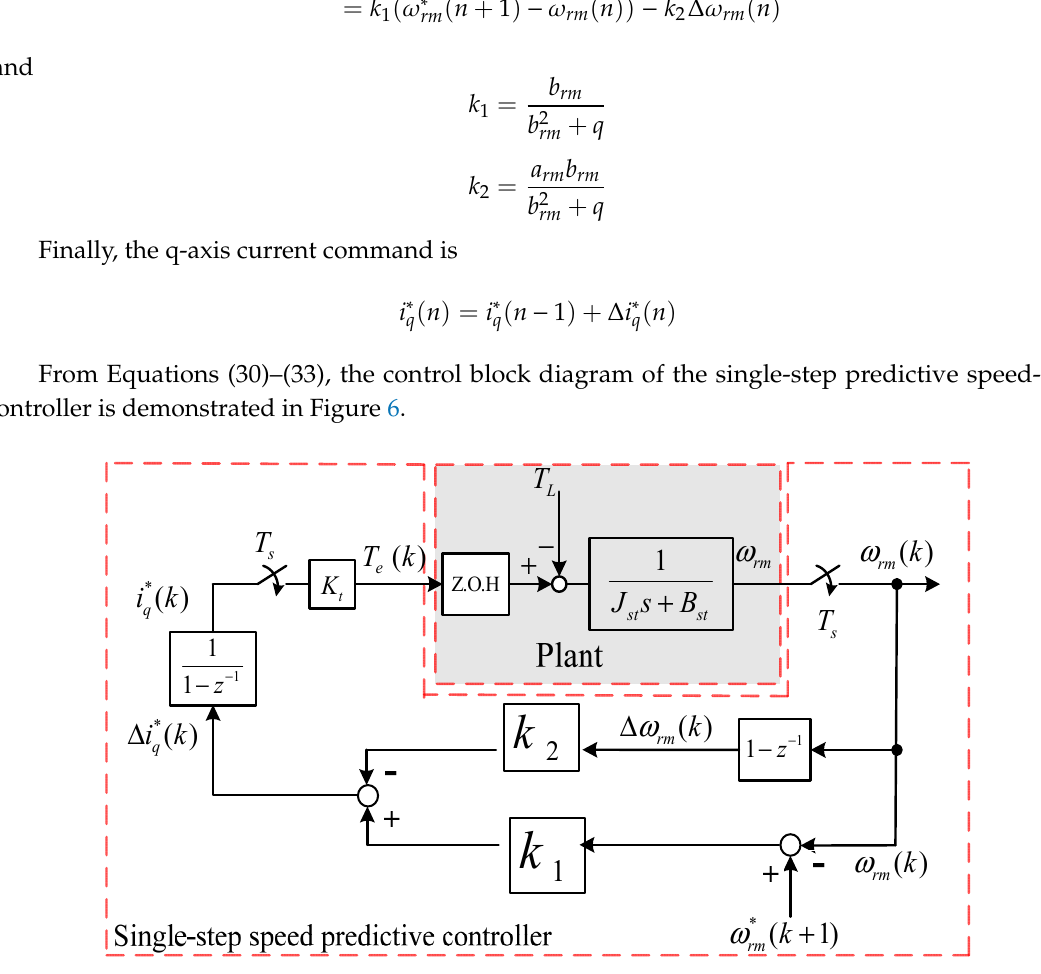
Figure 6. Single-step predictive speed controller.